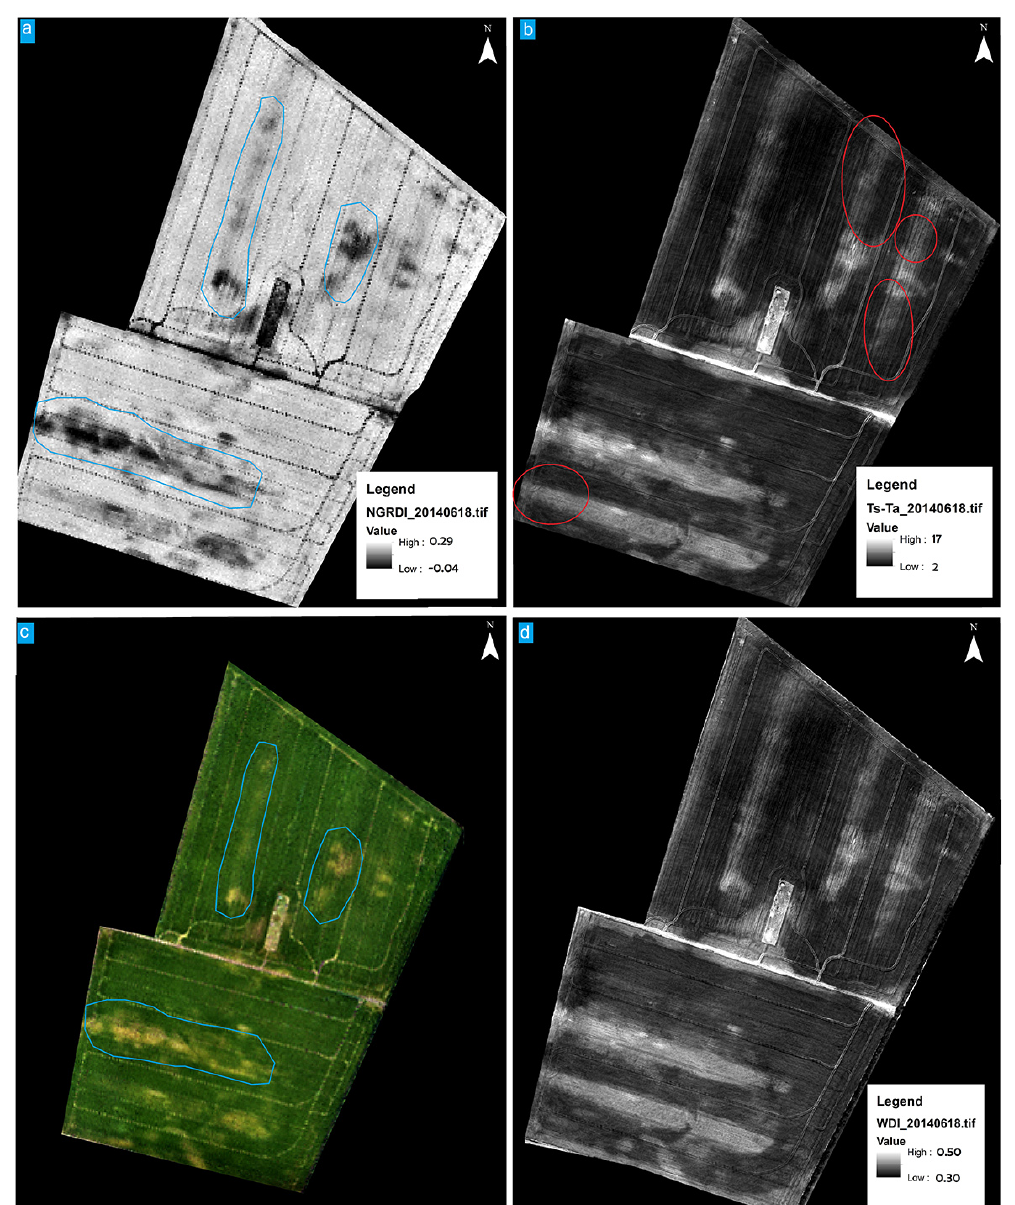
Figure 5. Imagery and indices from 18 June: (a) NGRDI, (b) T S − T A , (c) orthophoto (RGB data) and (d) WDI. Red circles in (b) are explained in Sect. 4.2. Areas highlighted with blue are examples of locations with ripe